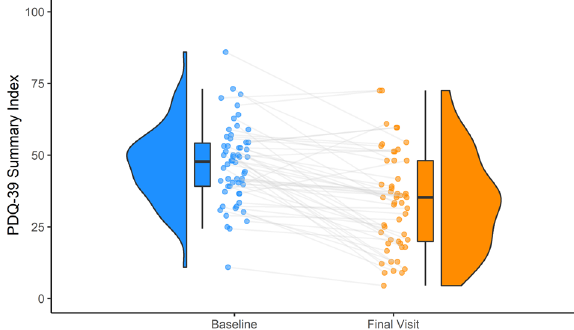
Fig. 2 PDQ-39 summary index evolution from baseline to fi nal visit. Violin plots representing the frequency and box plots representing the interquartile range containing 50% of the data, the median and the 95% con fi dence